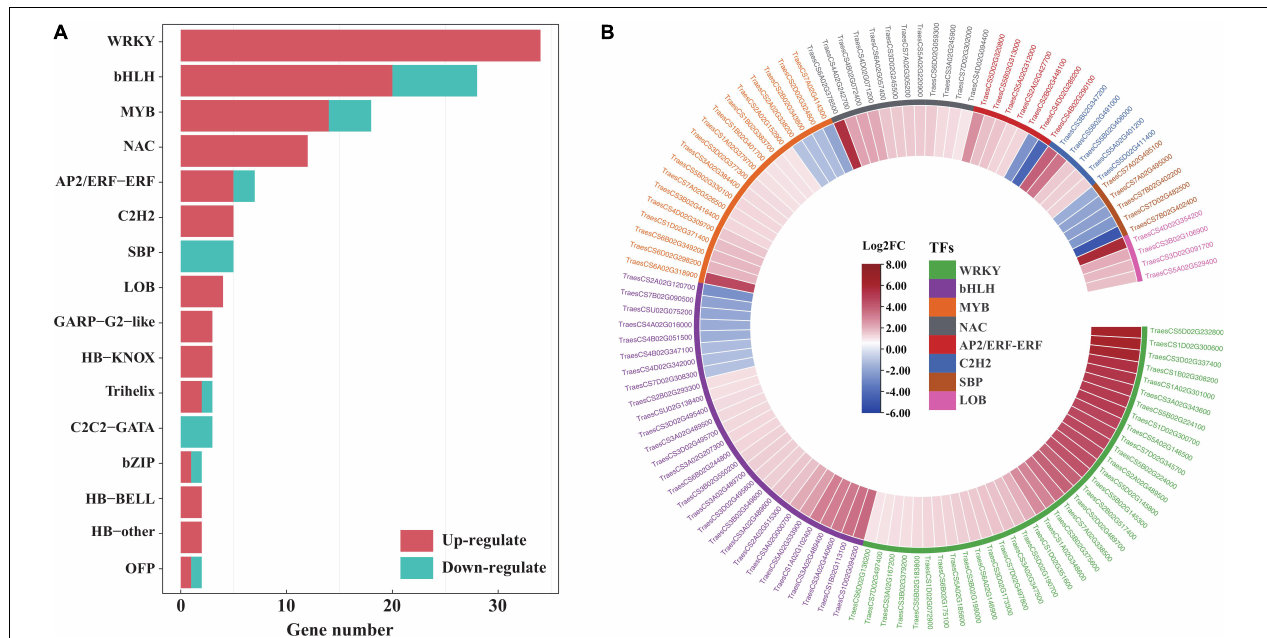
FIGURE 11 | Analysis of transcription factors in the leaf sheaths of EsMYB90 transgenic wheat compared with wild type upon salt shock. (A) Number distribution of the up/downregulated TF genes in different TF families. The red color bar indicates the upregulated and the blue color bar indicates the downregulated TF genes. (B) Expression analysis of the differential expressed TF genes in top 8 TF families using the heatmap. The differential transcript levels of TF genes calculated as Log 2 (TL/WT) are shown in the color legend, where red represents upregulated and blue represents the downregulated genes. The gene ID of the different TF families was shown in different colors.